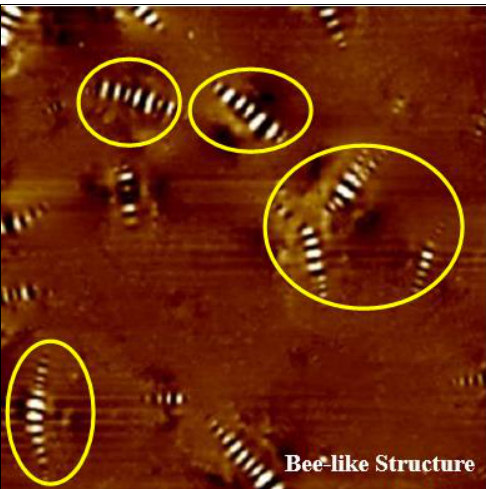
Figure 5. AFM Image of bee-like structures.